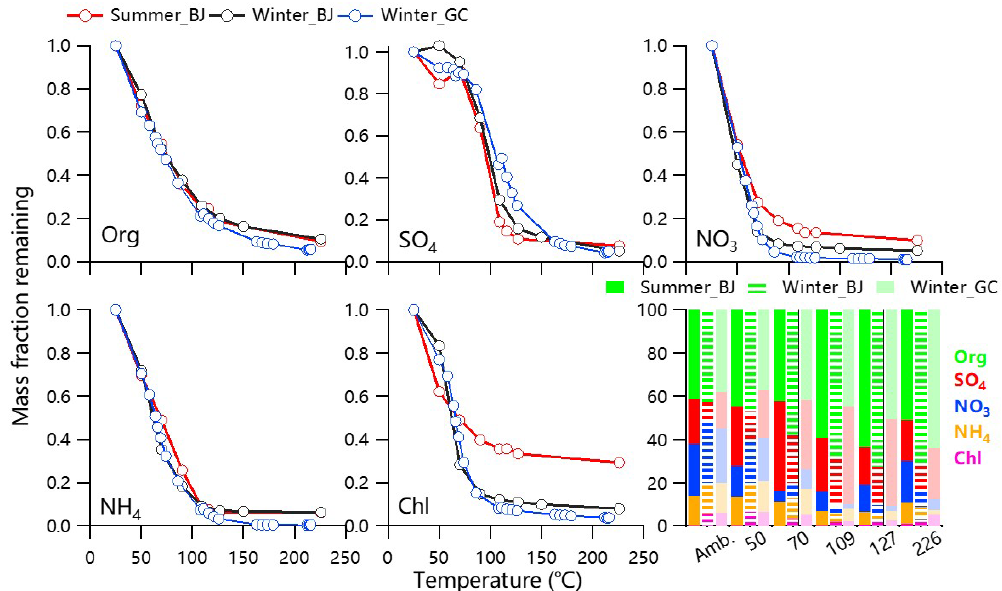
Figure 1. Thermograms of non-refractory submicrometer aerosol species including organics (Org), sulfate (SO 4 ), nitrate (NO 3 ), ammonium (NH 4 ) and chloride (Chl). The mass fractions of size-resolved non-refractory submicrometer aerosol (NR-PM 1 ) species as a function of TD temperature are also